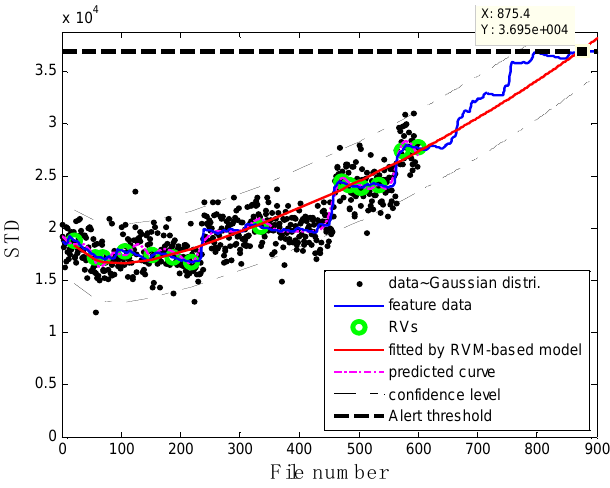
Figure 12. Inspection file